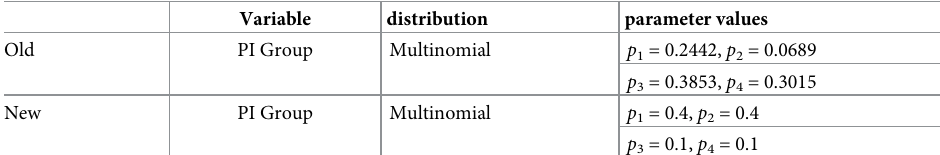
Table 9. Distribution of PI Group.